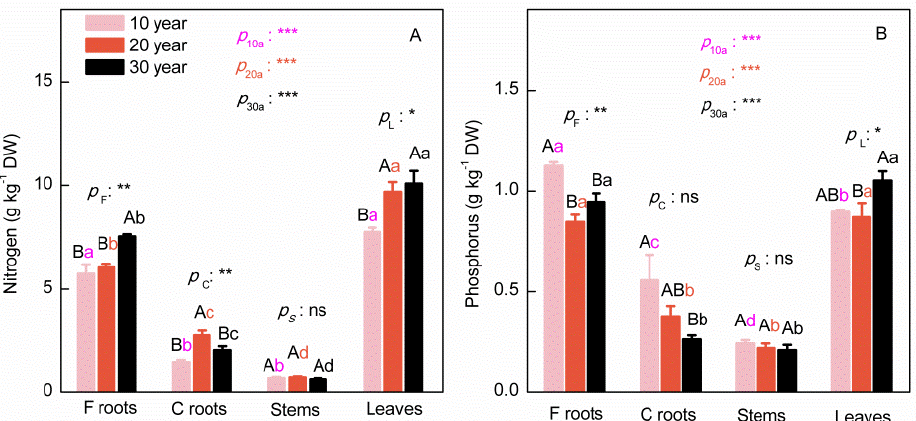
and stems were at their highest in 20-year-old Chinese fir (2.75 g kg − 1 and 0.69 g kg − 1 , respectively) and at their lowest in the 10- (1.47 g kg − 1 ) and 30-year-old (0.61 g kg − 1 ) plantations, respectively (Figure 3A).